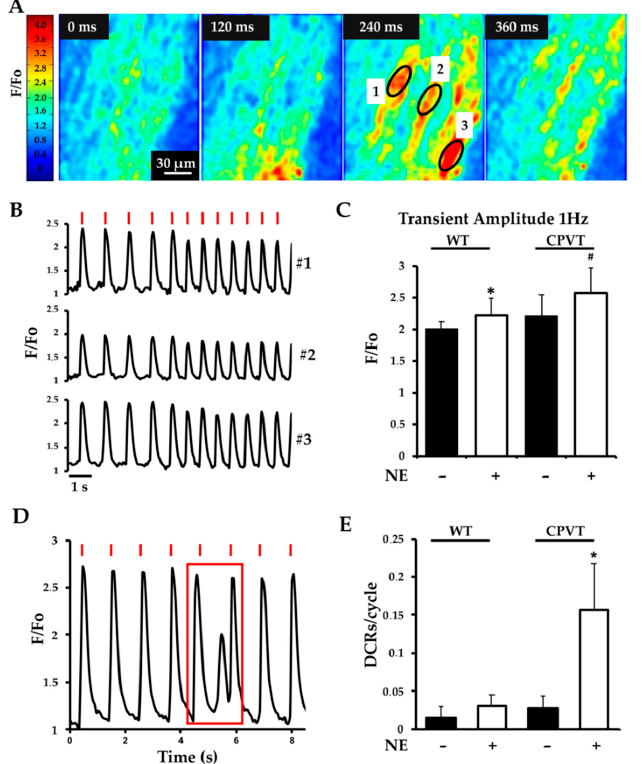
Figure 2. Multiphoton Ca 2+ imaging of Fluo-4-loaded myocardial slices. ( A ) Time course of Ca 2+ fluctuations in a heart slice, showing rises in fluorescence intensity, represented in pseudocolor (see reference bar on the left margin of the panel) upon electrical stimulation. F/Fo, normalized fluores- cence Ca 2+ signal intensity. ( B ) Fluorescence intensity profile of three different cells (in A , 240 ms) showing synchronized changes during electrical field stimulation. Stimulation pulses are indicated by the red lines. ( C ) Quantification of Ca 2+ transient amplitude, in both WT and CPVT heart slices, paced at 1 Hz, both in the absence (black bars) and in the presence (white bars) of norepinephrine (NE, 1 μ M) (* p < 0.05 (WT vs. WT + NE); # p < 0.05 (CPVT + NE vs. WT + NE) n = 30 cells/condition). ( D ) Representative trace of spontaneous Ca 2+ release events occurring between two consecutive beats (highlighted by the red box). ( E ) Quantification of SCRs in CPVT and WT slices, in unstimu- lated conditions and upon perfusion with NE (1 μ M). Bars represent SD (* p < 0.05 compared to CPVT-NE; n = 40 cells for each group).